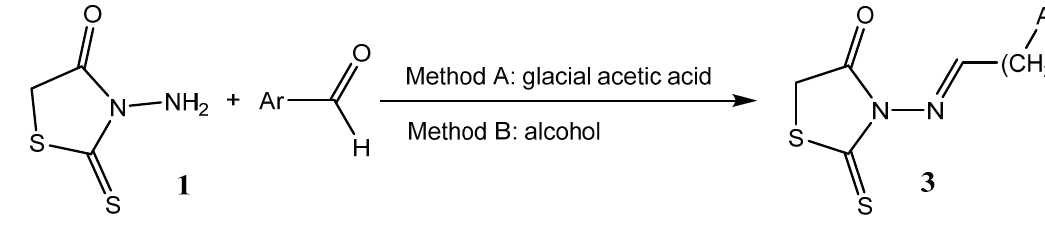
Scheme 1. Condensation of 3-aminorhodanine with an aldehyde in glacial acetic acid (method A) or alcohol (method